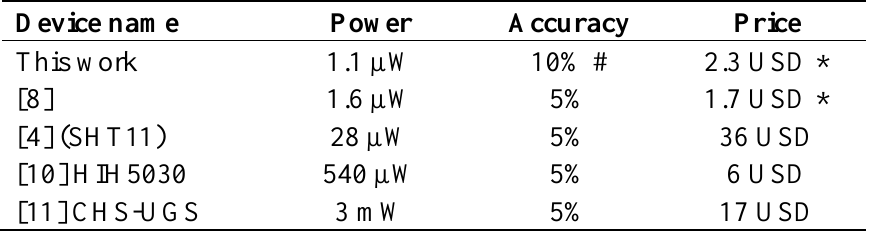
Table 2. Comparison of the humidity